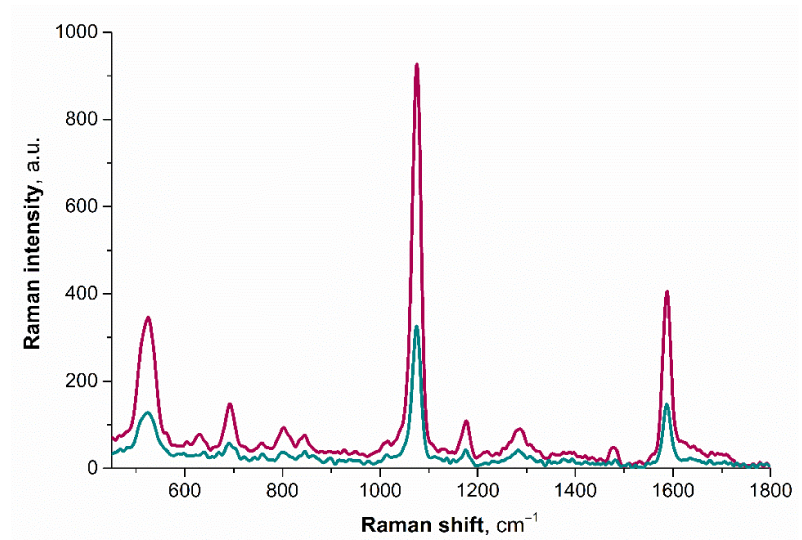
Figure 3. The SERS spectra of Raman active probe in the absence (red curve) and presence (green curve) of 100 ng/mL Hg 2+ (n =